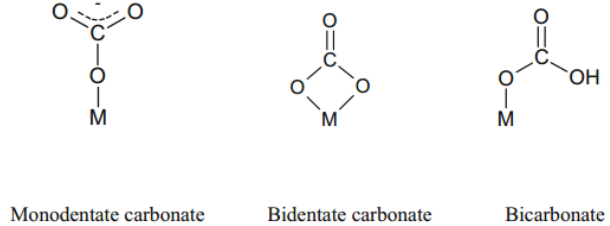
Figure 2. CO 2 molecules adsorb on alkali and/or alkaline earth metals by different species. Reproduced from Ref. [37], Copyright 2017, with permission from Springer.